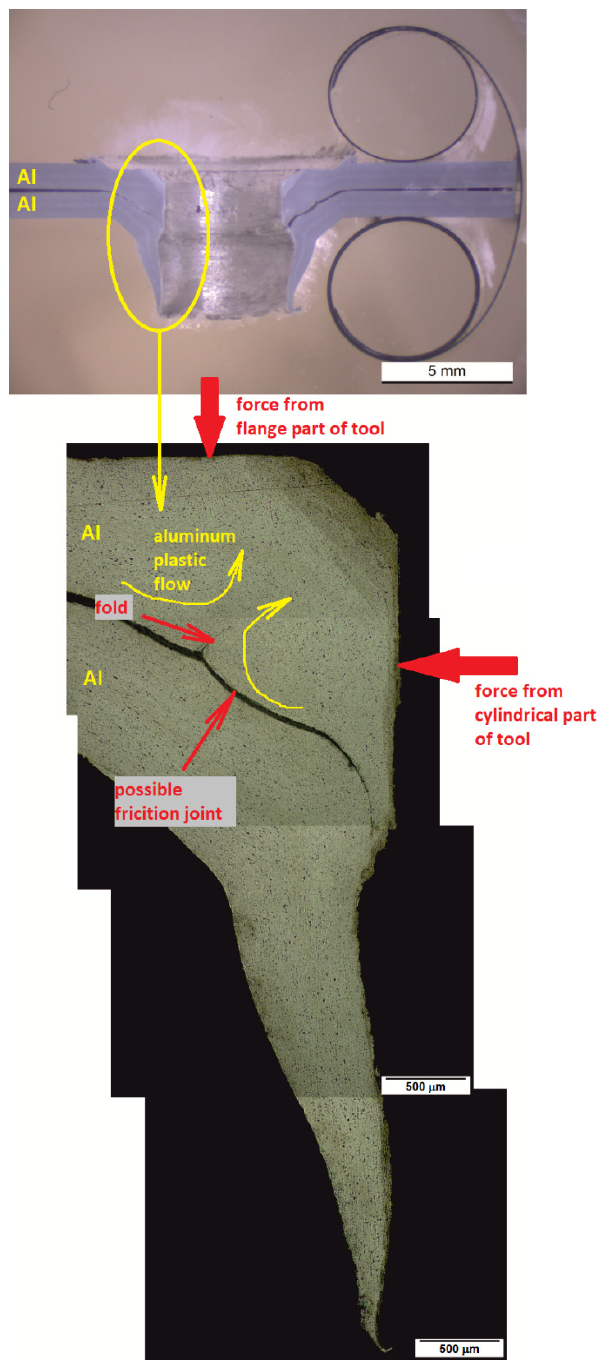
Figure 5. Cross section of Al-Al joint, etched: